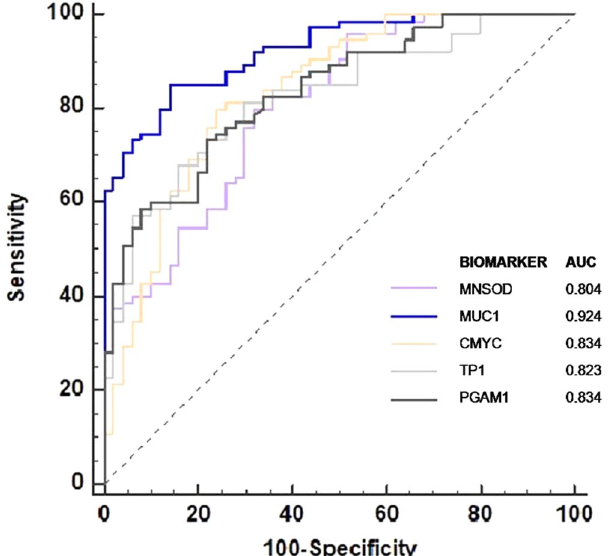
Figure 8. ROC analysis for individual autoantibody biomarkers: The area under the curve (AUC) for each individual autoantibody biomarker is more than 0.8 indicating the ability of individual assays to discriminate between CMT (n = 75) and healthy dog sera (n = 50). Comparison of ROC curves reveals maximum AUC for MUC1 biomarker followed by CMYC &